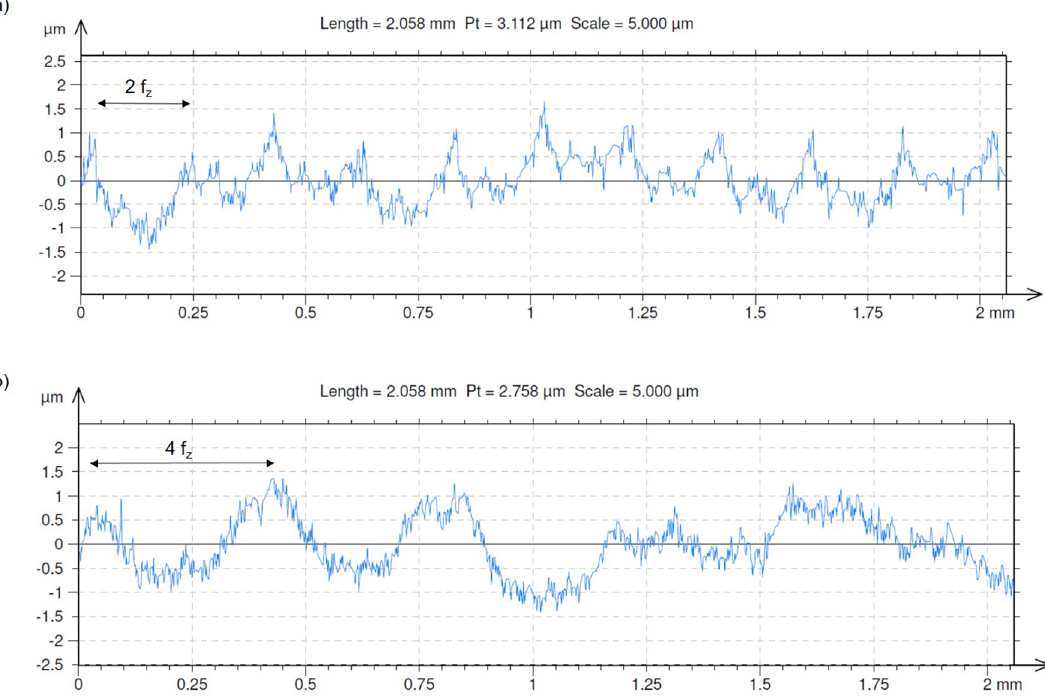
Figure 4. Surface profile along the feed direction (a) VDD, (b)